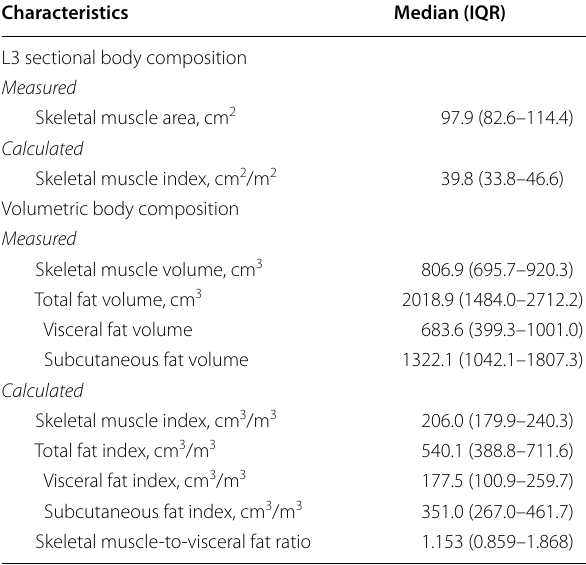
Table 1 Baseline body composition of all patients